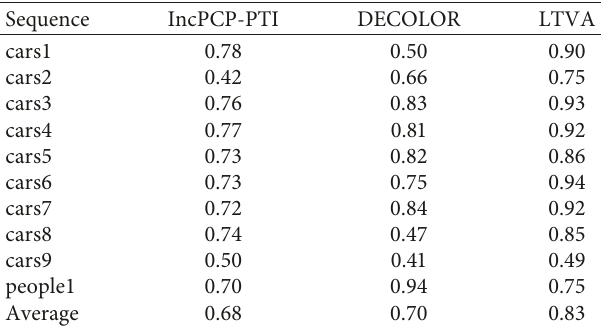
Table 2: Average F measure performance of incPCP-PTI, DECOLOR, and LTVA on the short panning Moseg sequences.